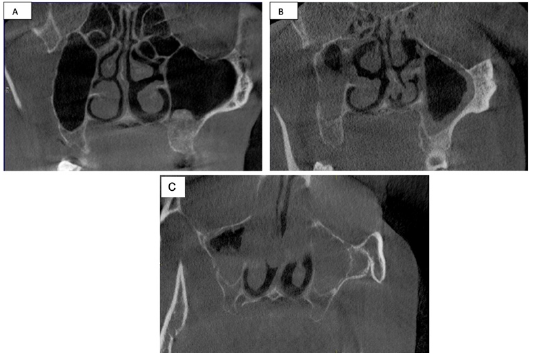
Figure 1. Measurement of CRS via Lund – Mackay staging system. ( A ) Coronal section of CBCT shows a score 0 for both right and left maxillary sinuses. ( B ) Coronal section of CBCT shows a score 1 (partial opacification) for both right and left maxillary sinuses. ( C ) Coronal section of the CBCT shows score 1 in the right maxillary sinus and score 2 (complete opacification) in the left maxillary sinus.